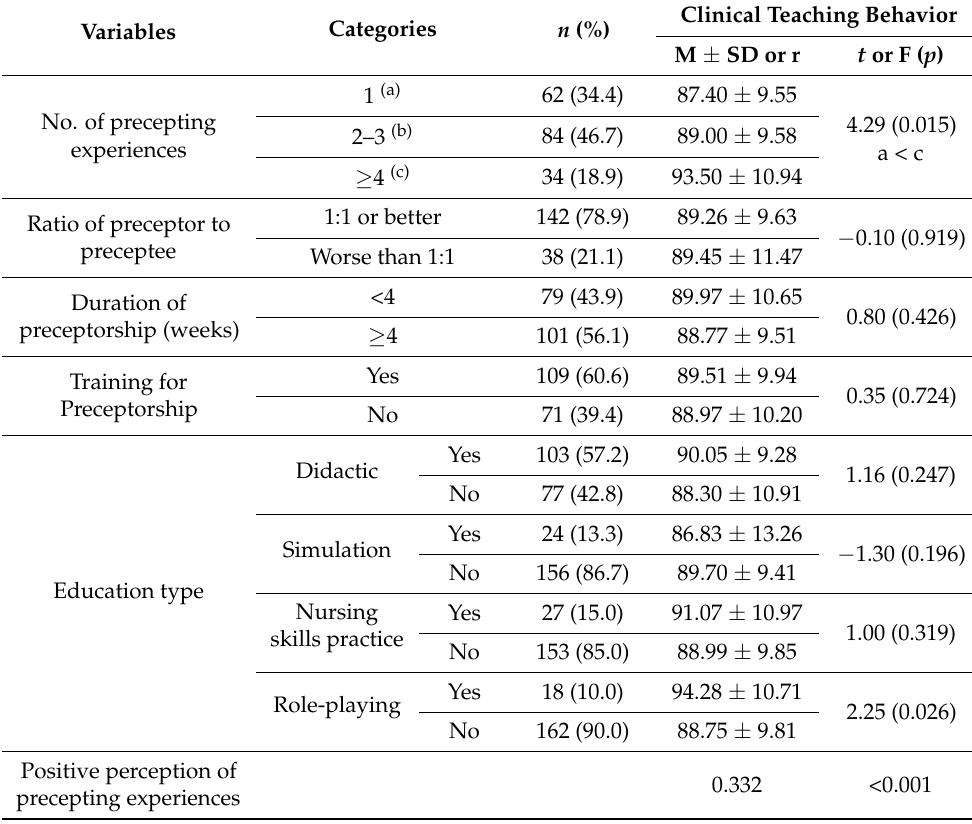
Table 4. Clinical teaching behavior according to general characteristics and correlations with percep- tions of precepting experiences ( n =